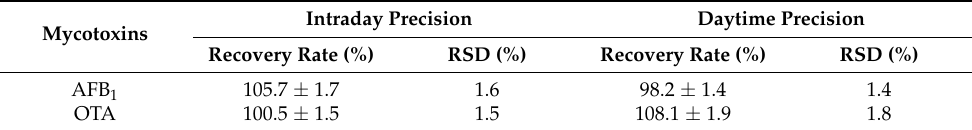
Table 6. HPLC instrument precision.